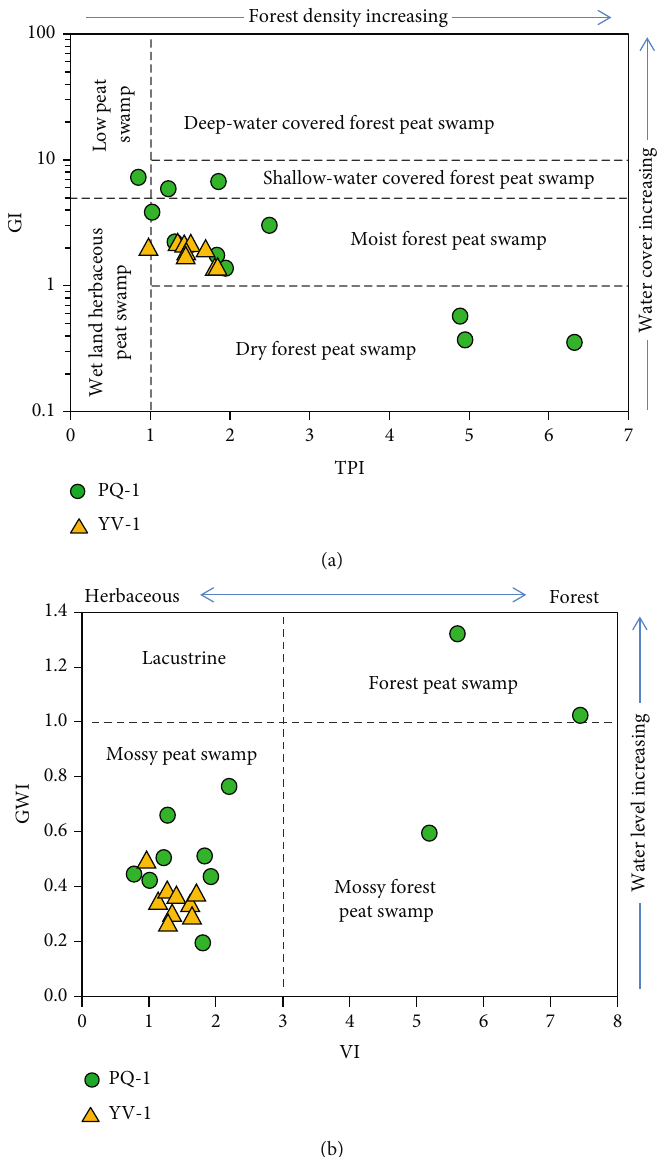
Figure 4: GI-TPI cross-plot (a) (modi fi ed from [28]) and GWI-VI cross-plot (b) (modi fi ed from [30]) for identifying coal